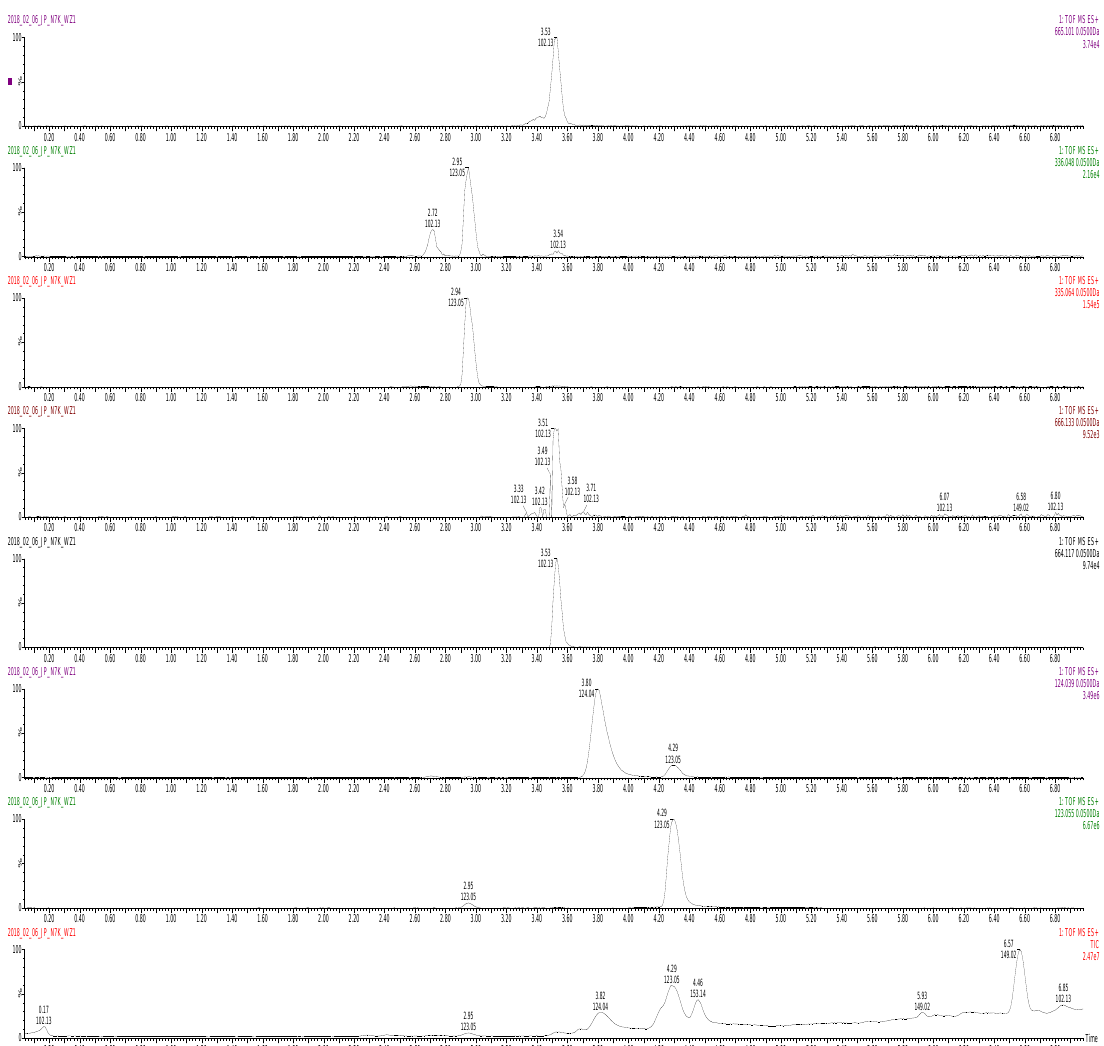
Figure 1. Total ionic current (TIC) chromatogram for patient exemplified sample. Data represent single ion current chromatograms for particular metabolites (NAAD, NAMN, NMN, NADH, NAD, NA and NAM, from the top) from with their retention times on horizontal axis and total ion current on the bottom chromatogram for patient sample.